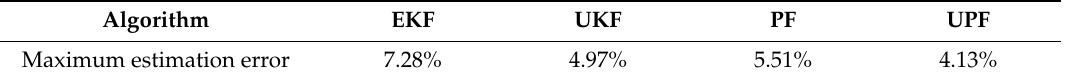
Figure 17. SOC estimation error curves of different algorithms under open-circuit voltage disturbances.